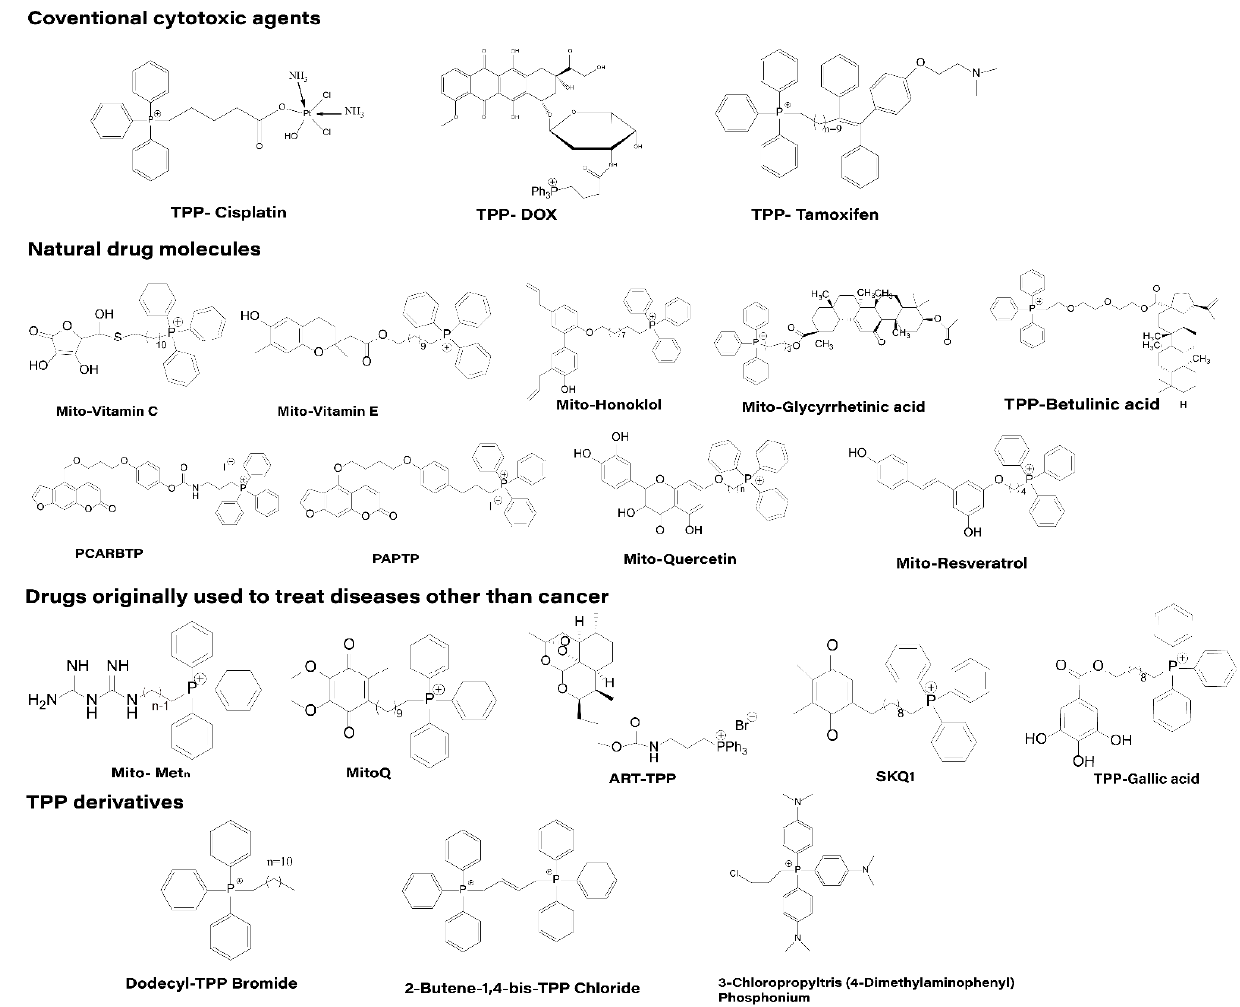
Figure 5. Four categories of the anticancer drugs directly conjugated to TPP: (1) Conventional cytotoxic agents, (2) natural drug molecules, (3) drugs originally used to treat diseases other than cancer, and (4) TPP derivatives.